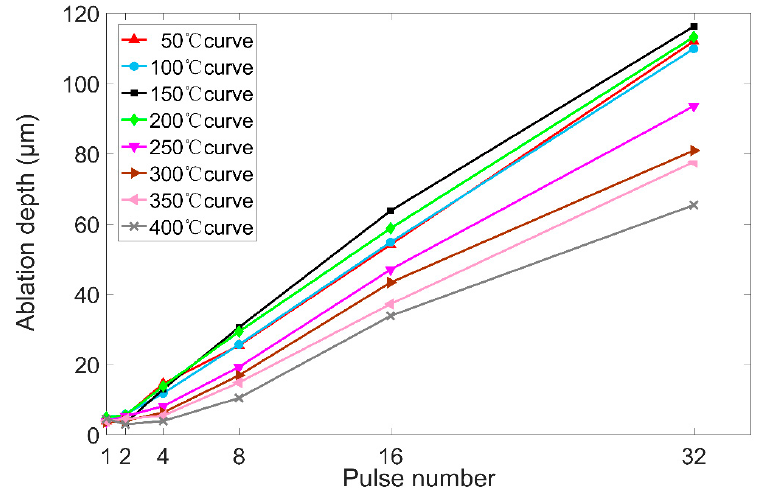
Figure 13. Ablation depth–pulse number curves at substrate temperatures of 50 °C–400 °C.